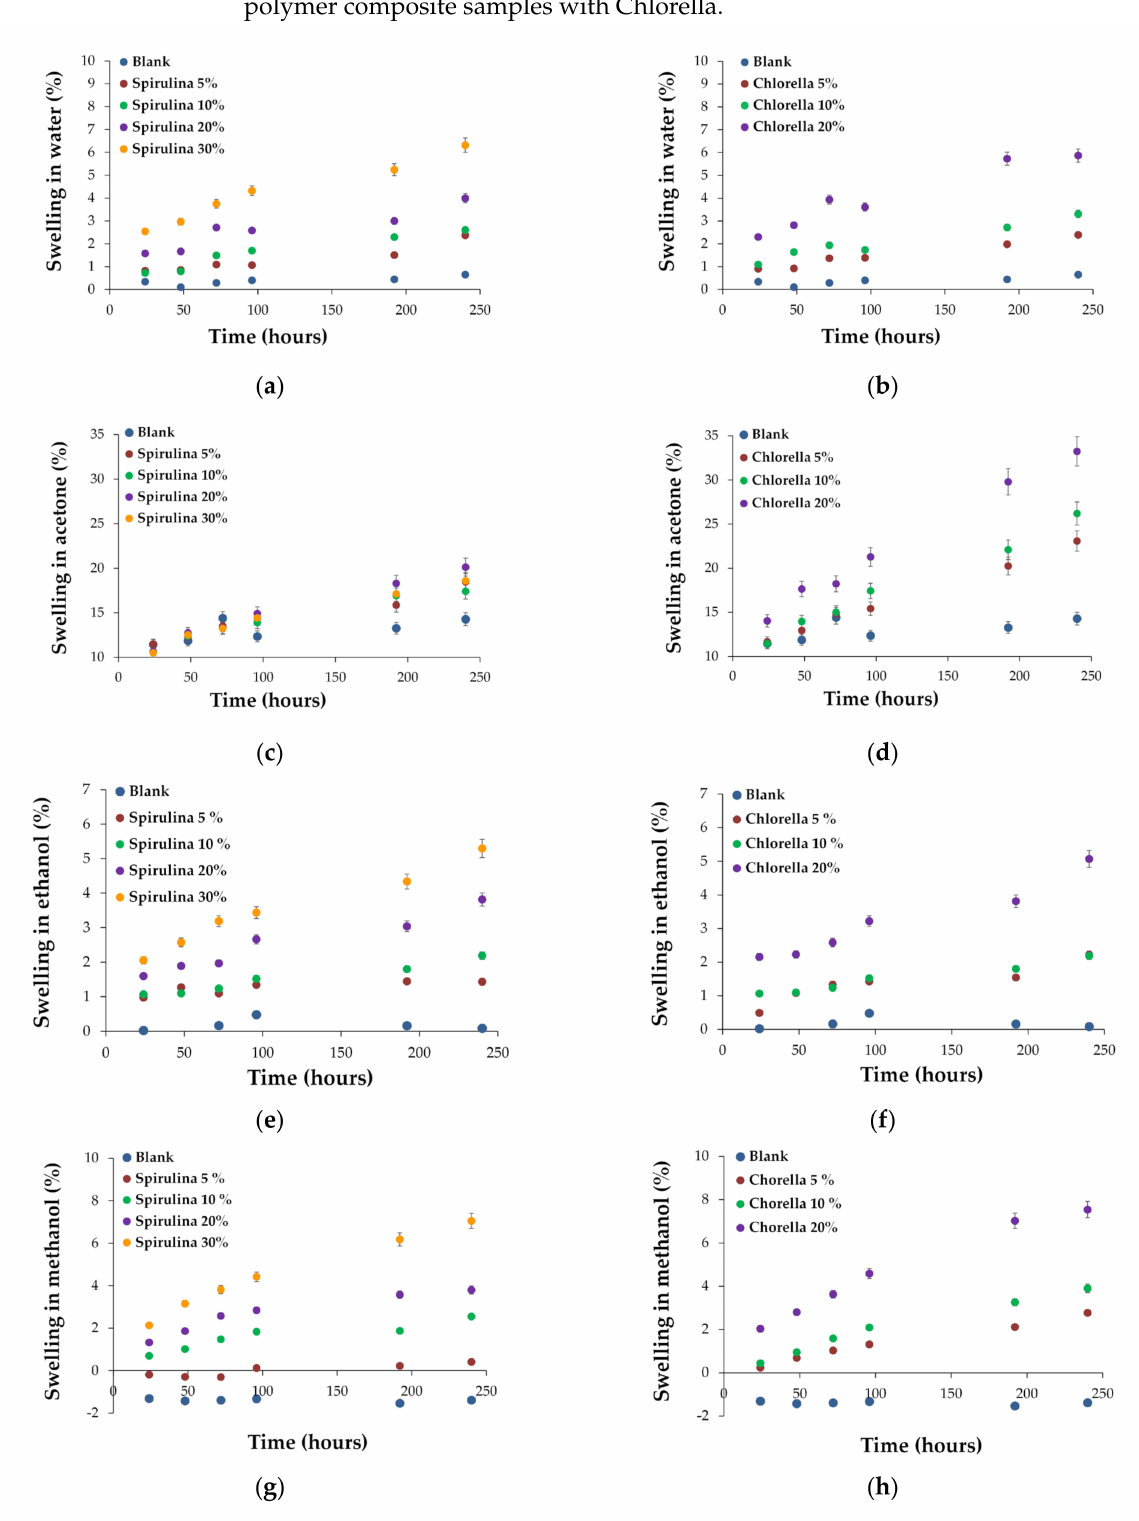
Figure 10. Swelling of MSBS with Chlorella and Spirulina in water ( a , b ), acetone ( c , d ), ethanol ( e , f ), and methanol ( g , h